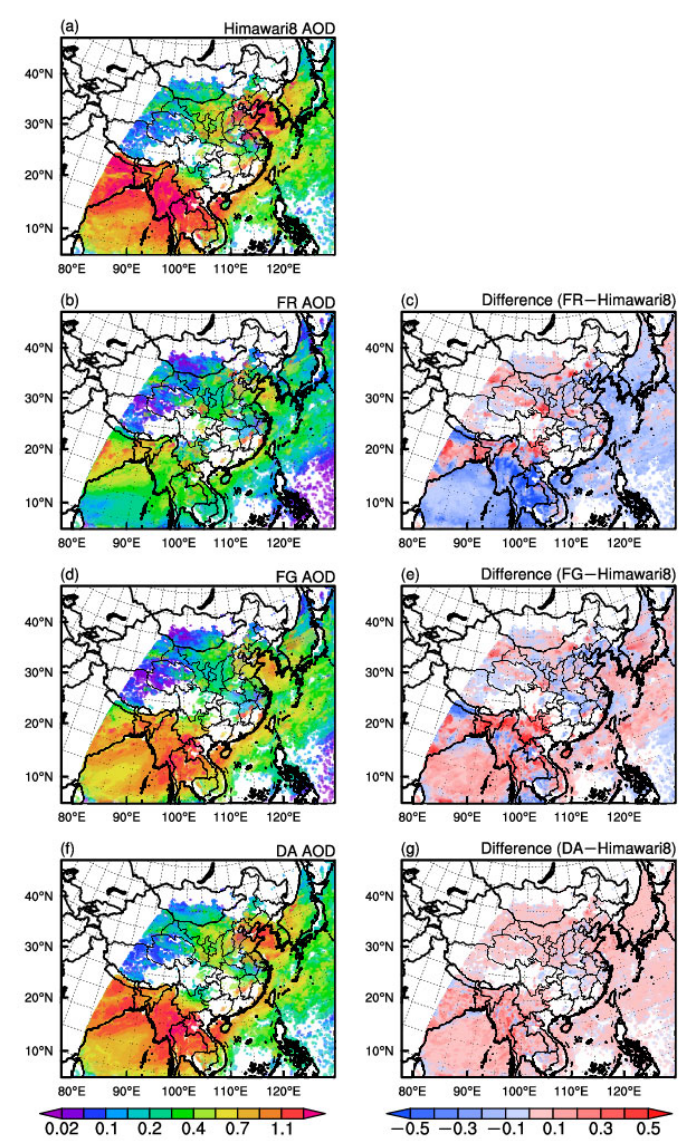
Figure 4. Spatial distributions of the mean AODs ( a ) observed by the Himawari-8, simulated in the ( b ) FR experiment, ( d ) first guess (FG, a priori), and ( f ) analyses (DA) in the DA experiment and their differences ( c , e , g ) with Himawari-8 at daily 06:00 UTC from 8 to 22 March 2021.